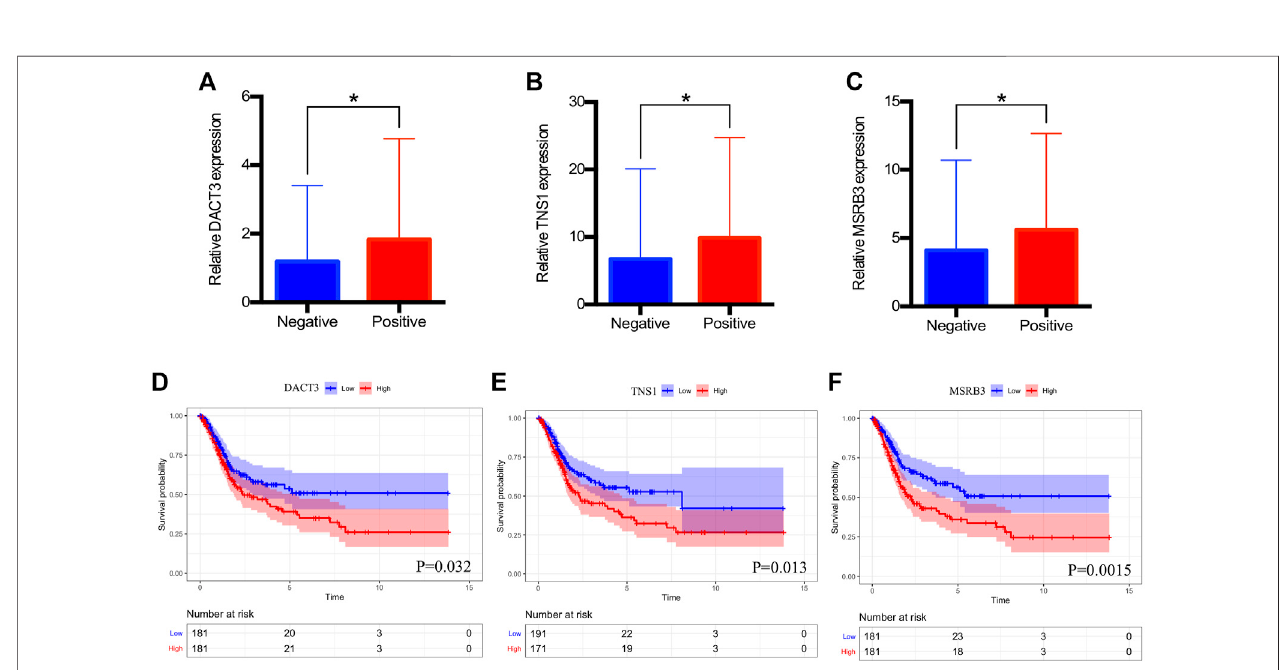
FIGURE 5 | Clinical signi fi cance of DACT3, TNS1, and MSRB3. (A – C) Relative expression of DACT3, TNS1, and MSRB3 in patients with negative and positive lymph nodes. (D – F) Overall survival of patients with low and high expressions of DACT3, TNS1, and MSRB3. The asterisks mean p < 0.05.